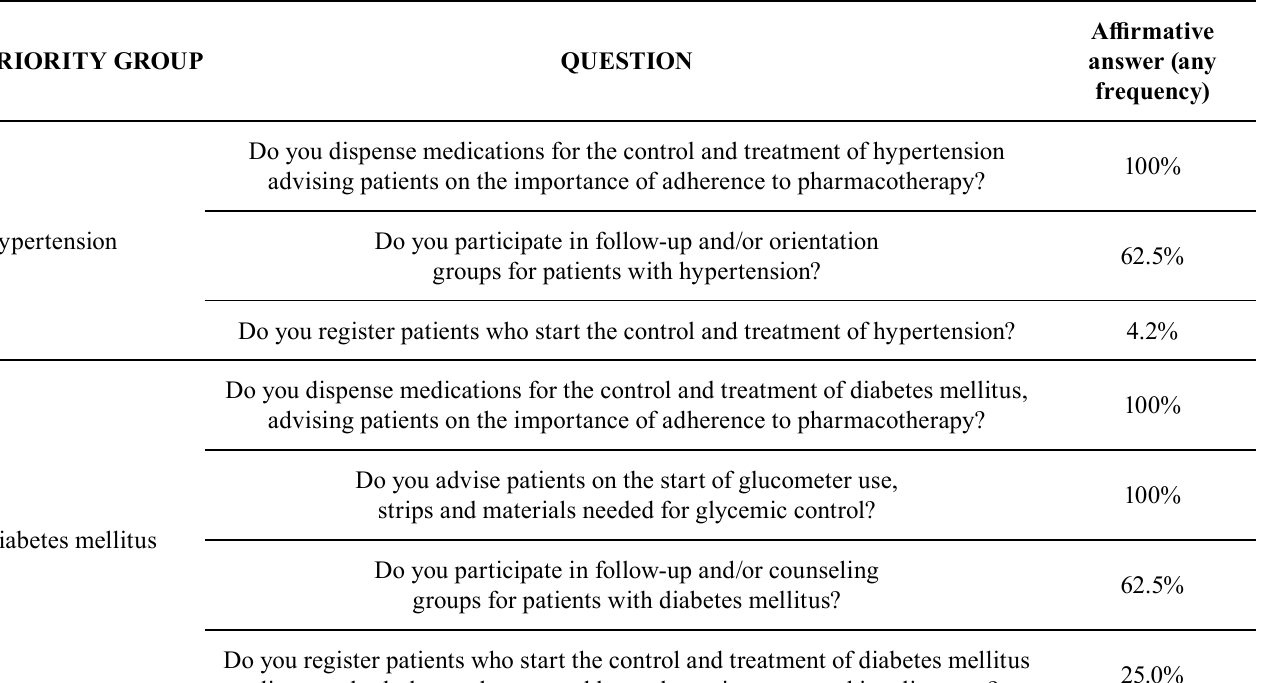
TABLE VI – Pharmaceutical Care activities carried out in priority groups in primary health center (UBS) of São Bernardo do Campo,